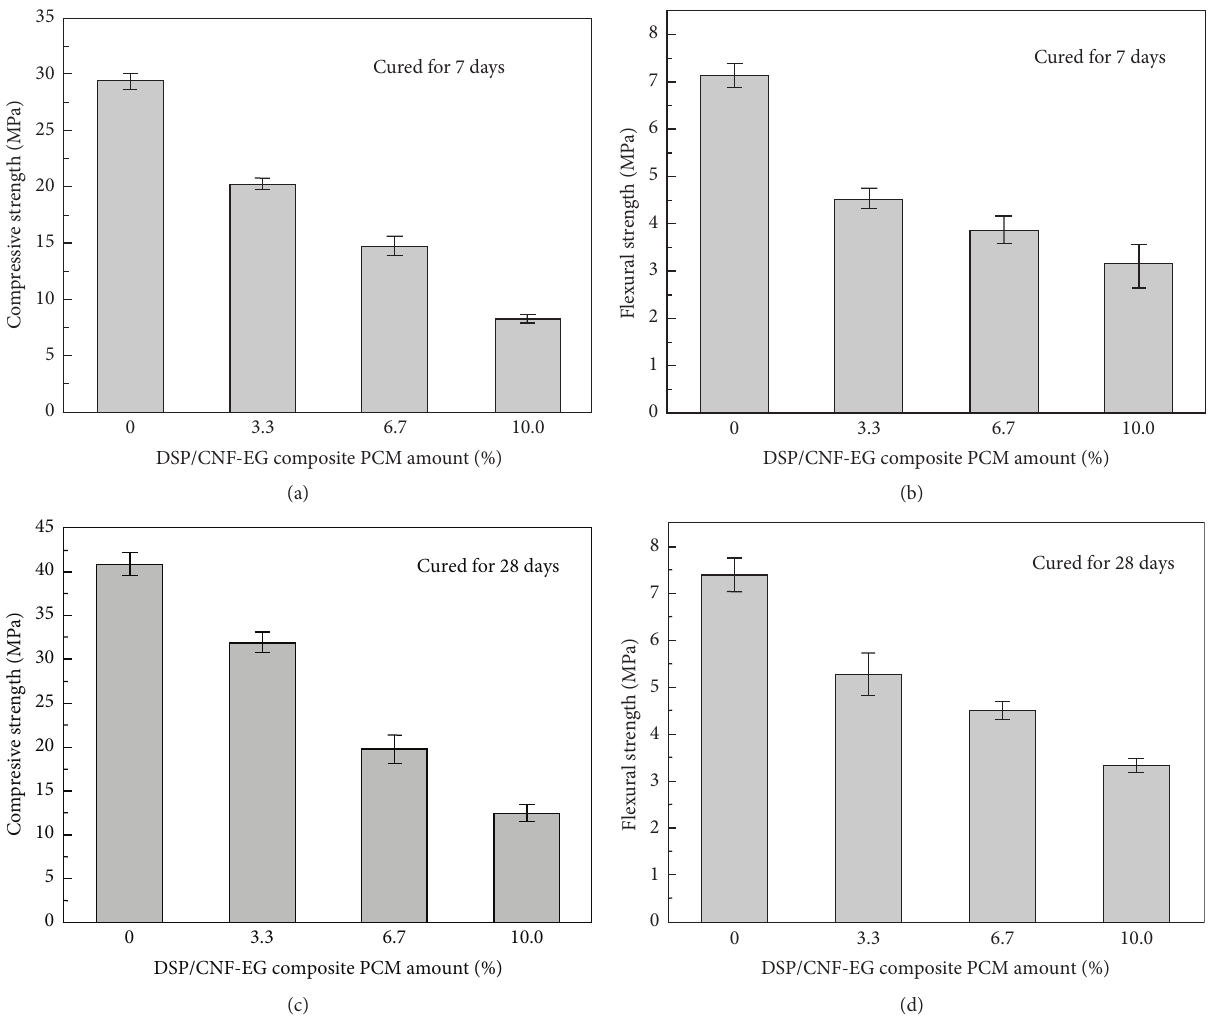
Figure 4: Compressive strength and flexural strength of CM and DSP/CNF-EG/CM samples with different curing periods: compressive strength cured for (a) 7 days and (c) 28 days and flexural strength cured for (b) 7 days and (d) 28